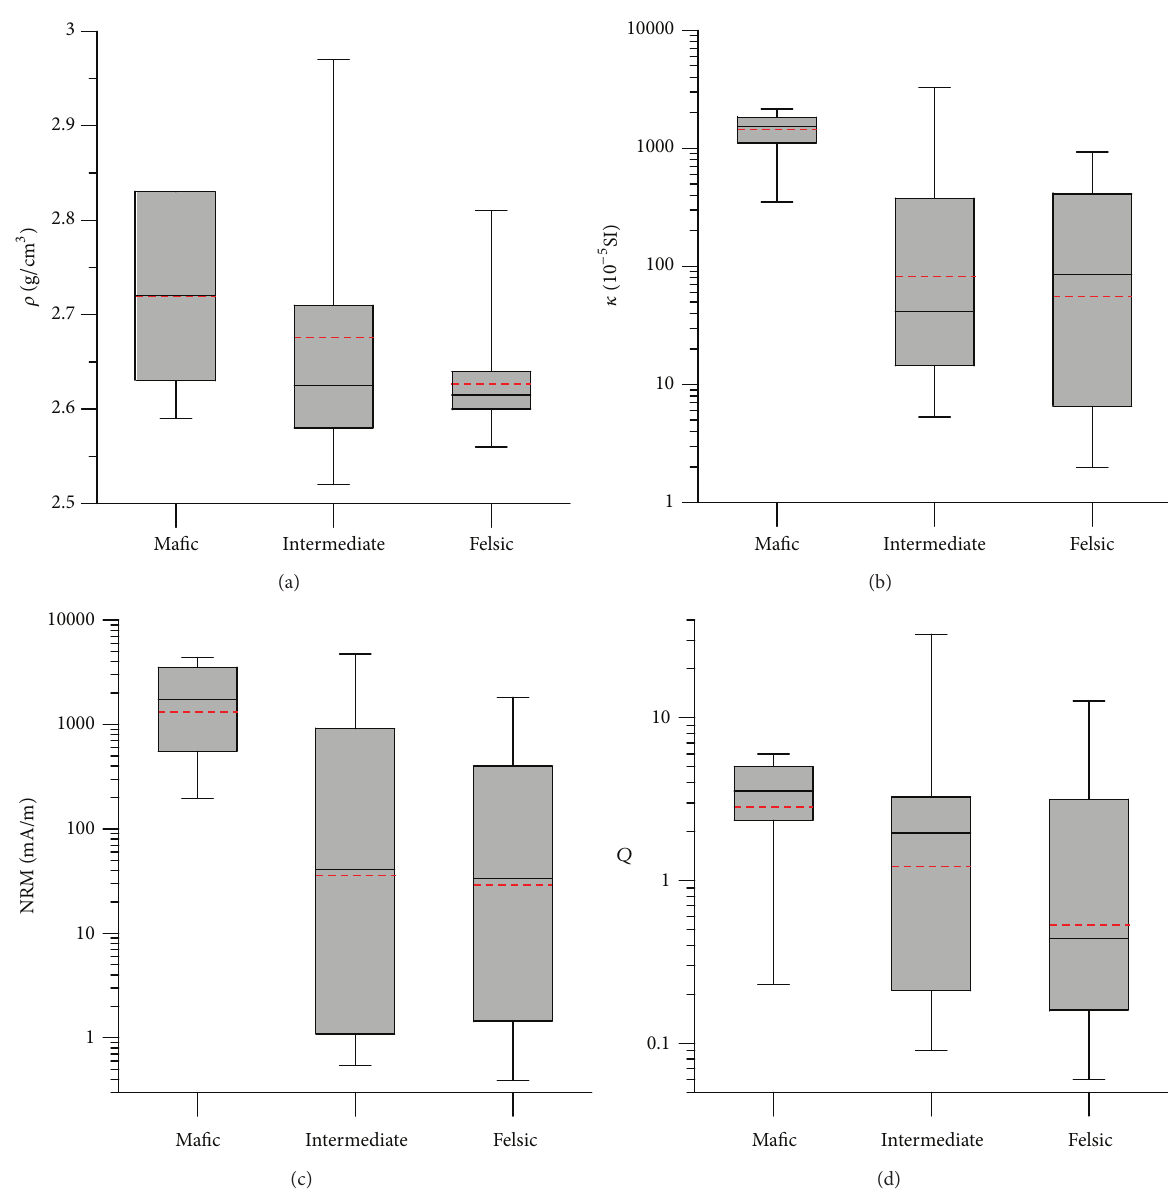
Figure 5: Box plot for (a) 𝜌 , (b) 𝜅 , (c) NRM, and (d) 𝑄 of basic, intermediate, and felsic igneous rocks. Red dash lines indicate the average values of the corresponding petrophysical parameters.